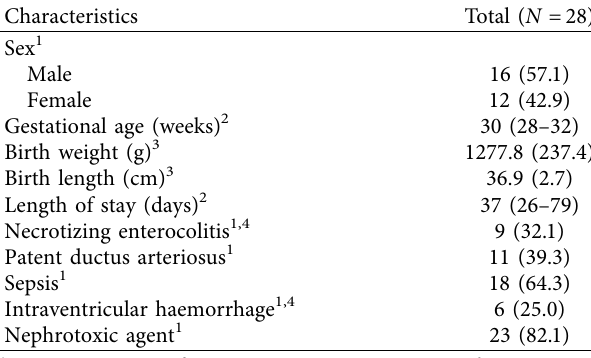
1 n (%) is presented. 2 Median (min–max) is presented. 3 Mean (SD) is presented. 4 n �